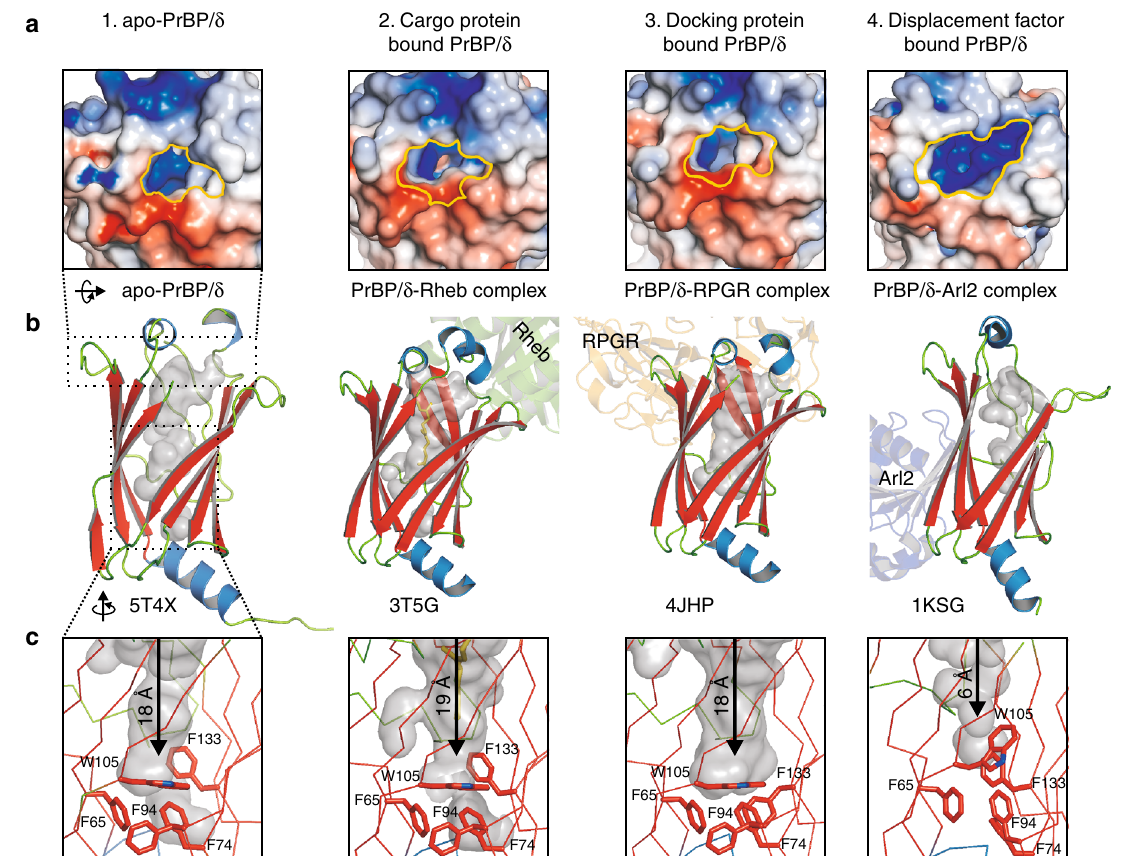
Fig. 2 Prenyl-binding protein (PrBP/ δ ) crystal structures in various conformations. a Electrostatic surface representation of prenyl-binding protein (PrBP/ δ ) crystal structures. Electrostatic surface potentials were calculated using the program APBS with the non-linear Poisson – Boltzmann equation and contoured at ± 5 kT e − 1 78 . Negatively and positively charged surface areas are colored in red and blue, respectively. To elucidate the entrance of the cavity a yellow edge was introduced manually. The structured loop above the entrance in the PrBP/ δ -Rheb-bound complex was removed in front for clarity. The cavity entrance of the three open conformations of PrBP/ δ (PDB entries 5T4X, 3T5G, 4JHP) are more similar compared to the entry site of the displacement factor bound PrBP/ δ in the closed conformation (PDB entry 1KSG). The apparent larger cavity entrance in 1KSG is a result of the increased fl exibility in the fl exible loop above the entrance. Moreover, the closure of the cavity results in an electrostatic surface potential rearrangement which may facilitate the release of the cargo. b Overall fold of PrBP/ δ in cartoon representation with the hydrophobic cavity depicted as gray surface. The C15-farnesyl-moiety in the cargo-bound form is shown as yellow sticks. Binding partners of PrBP/ δ are depicted in cartoon representation for clarifying the different additional protein interfaces in contrast to apo-PrBP/ δ . c Close-up view of the PrBP/ δ binding cavities. The PrBP/ δ binding cavities are shown as ribbon representations and surfaces (gray). Key aromatic residues Phe65, Phe74, Phe94, Trp105, and Phe133, which de fi ne the bottom of the hydrophobic pockets for all selected crystal structure conformations, are depicted as stick representation. In particular, Phe94 and Trp105 of PrBP/ δ indicate a rotation of their side chains after complex formation with the displacement factor (PDB entry 1KSG) and thereby a signi fi cant reduction of the cavity. Therefore, the PrBP/ δ – Arl2 complex is incapable of incorporating any C15- or